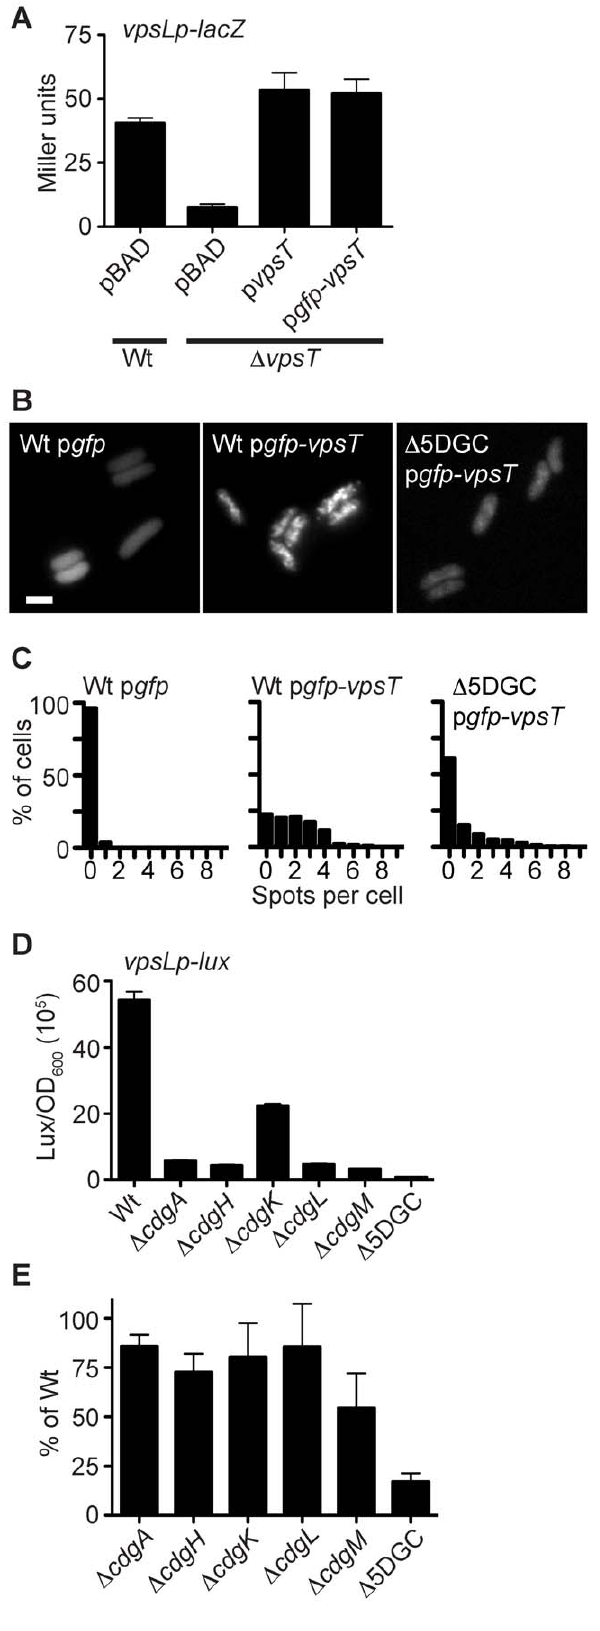
Figure 1. VpsT Localization is Dependent on Multiple Digua- nylate Cyclases. (A) The expression of a chromosomal vpsL promoter- lacZ fusion was measured in wild type (Wt) or D vpsT strains containing pBAD vector alone, or pBAD containing vpsT or gfp - vpsT using b - galactosidase assays. One representative experiment of three biological replicates is shown. Error bars indicate standard deviations of eight technical replicates. (B) Representative epifluorescence micrographs are shown of the subcellular localization of GFP or GFP-VpsT fusion protein in wild-type or D 5DGC V. cholerae strains. Marker is 2 m m. (C) Single-cell quantification of subcellular fluorescence localization. The number of spots per cell is shown as a histogram for wild type or D 5DGC strains expressing GFP or GFP-VpsT. Data are acquired from at least 3 independent experiments and quantification was performed on at least 150 cells per treatment. (D) Expression of the vpsL promoter fused to a lux reporter operon in wild-type V. cholerae (Wt) or strains containing single in-frame deletions of the genes encoding DGCs cdgA , cdgH , cdgK , cdgL , cdgM or a strain containing in-frame deletions all 5 DGCs ( D 5DGC). Expression is reported in luminescence counts min 2 1 ml 2 1 /OD 600 nm . One representative experiment of three biological replicates is shown. Error bars indicate standard deviations of four technical replicates. (E) Percent c-di-GMP levels of single in-frame deletion DGC mutants or the D 5DGC strain compared to wild type V. cholerae using high- performance liquid chromatography-tandem mass spectrometry. Error bars indicate standard deviations of three biological